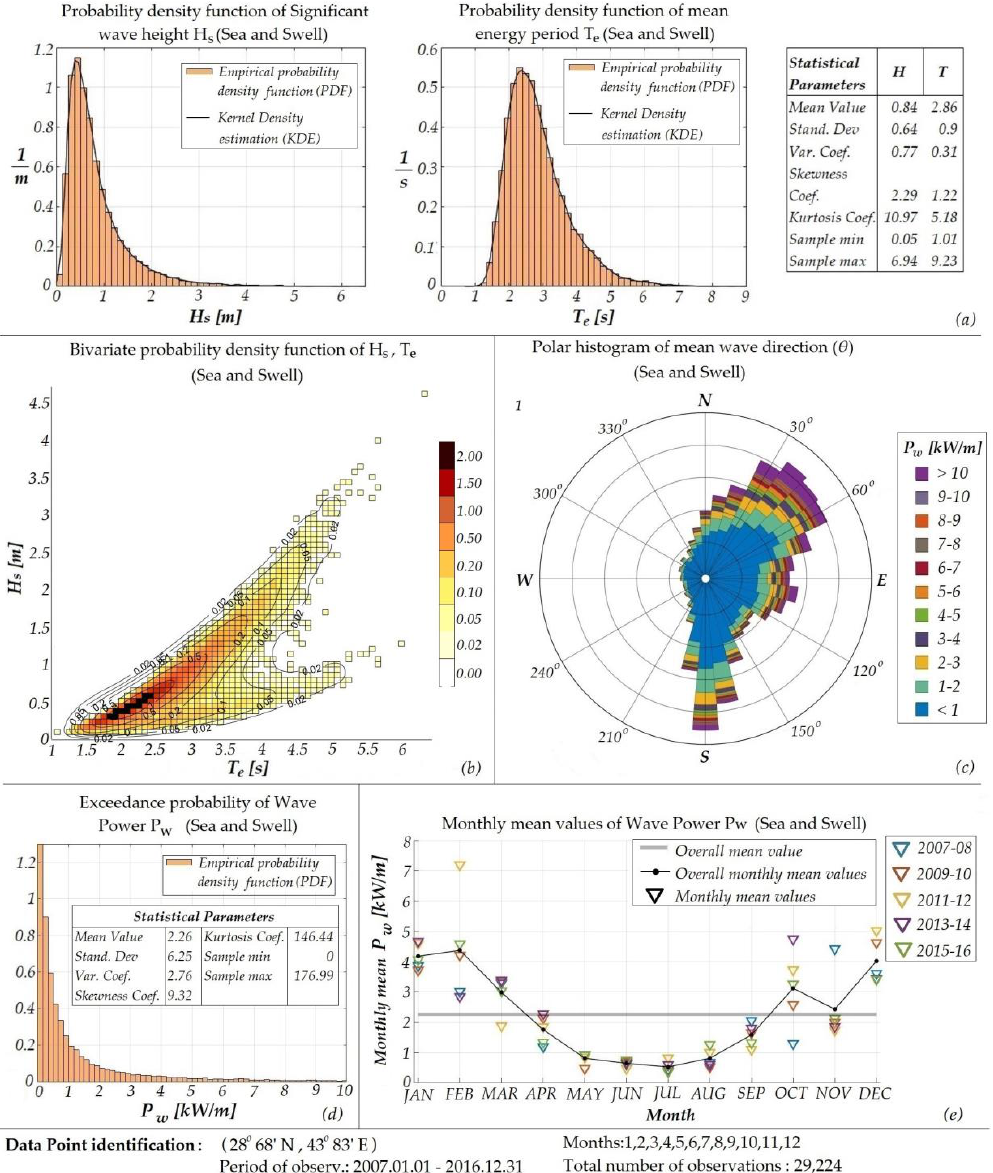
Figure 13. Annual distribution of wave parameters and wave potential at the nearshore area of TP.